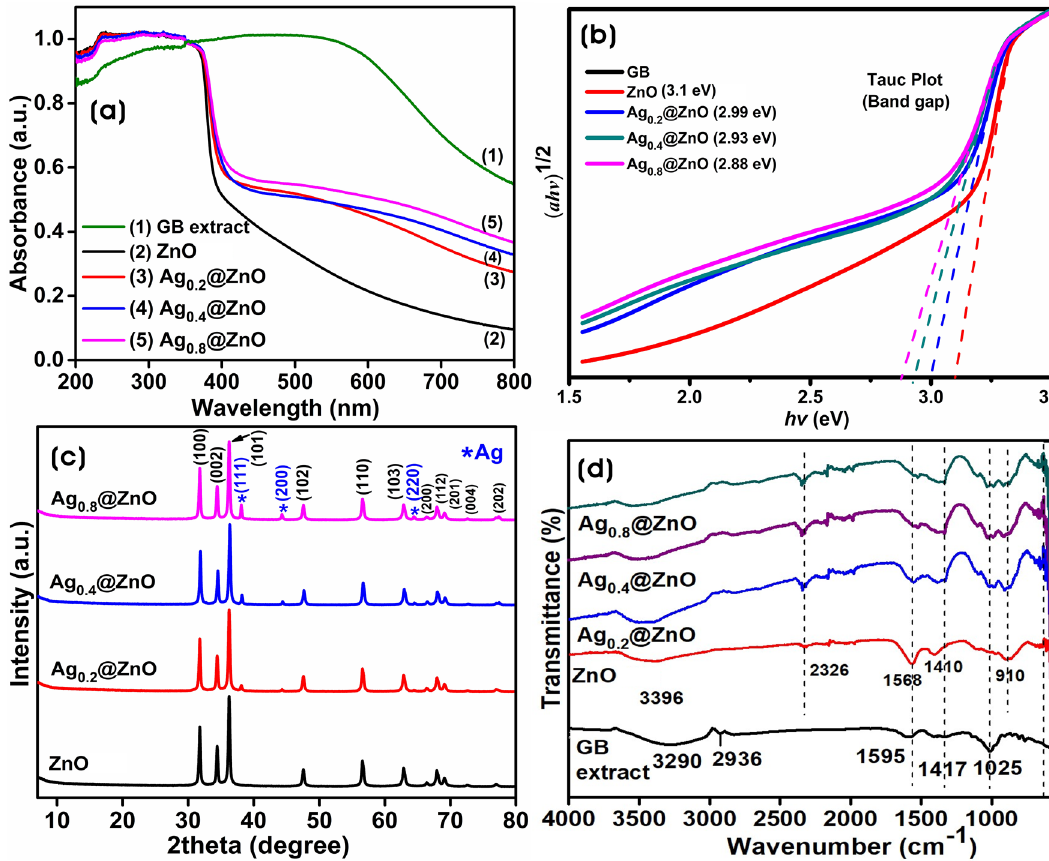
Figure 2. ( a ) UV–Vis DRS absorption spectra, ( b ) Tauc plots, ( c ) Powder XRD analyses, and ( d ) FTIR spectra of ZnO, Ag 0.2 @ZnO, Ag 0.4 @ZnO, and Ag 0.8 @ZnO